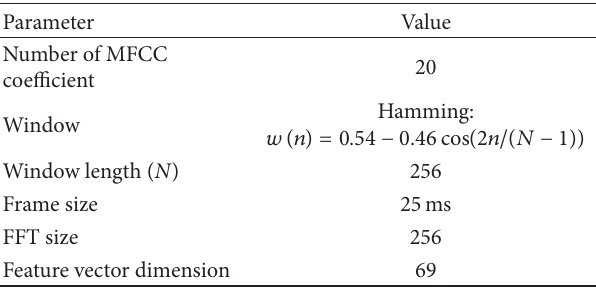
Table 1: MFCC parameters used in feature extraction of cough